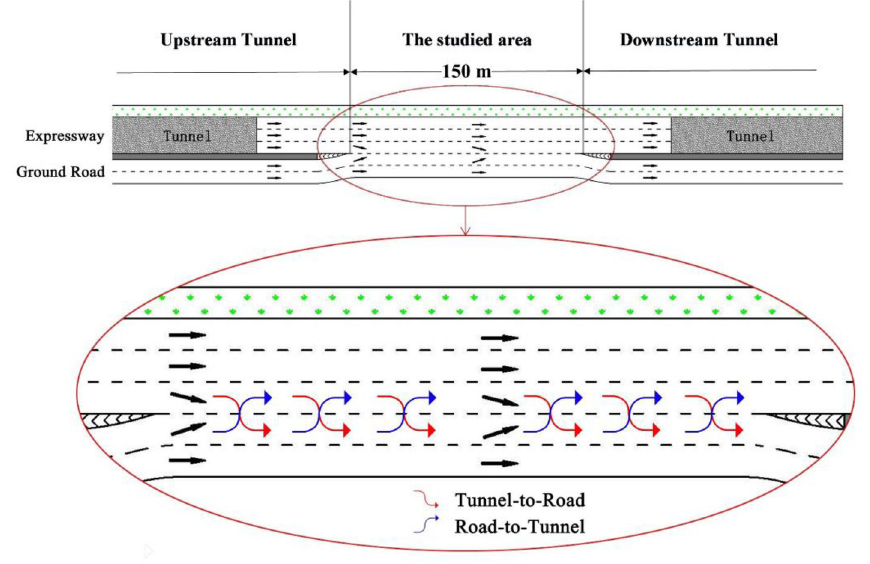
Fig 2. Geometric structure and two weaving traffic streams of weaving